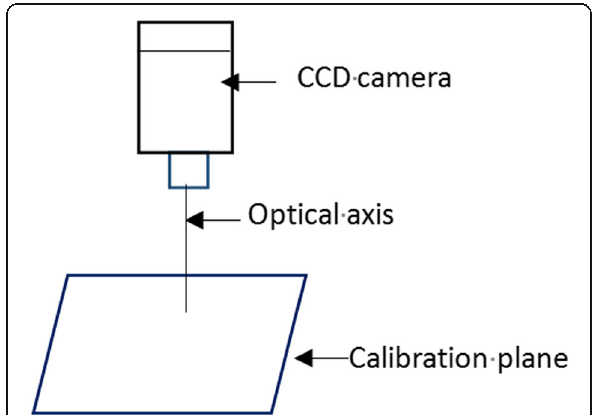
Fig. 2 Schematic diagram of machine vision